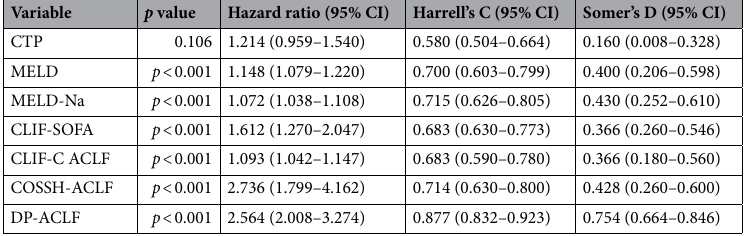
Table 7. Validation group: univariate Cox regression analysis of survival time and ACLF status with DP-ACLF and other prognostic scoring systems.